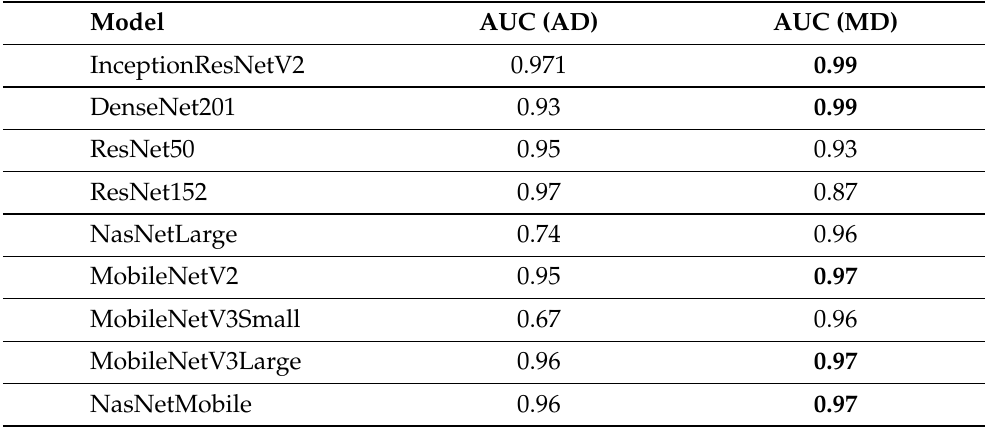
Table 7. AUCs of all models. AD stands for augmented data, this indicates that the model is trained with augmented data. MD stands for metadata, which indicates that the model is trained with metadata. Bold numbers highlight the highest